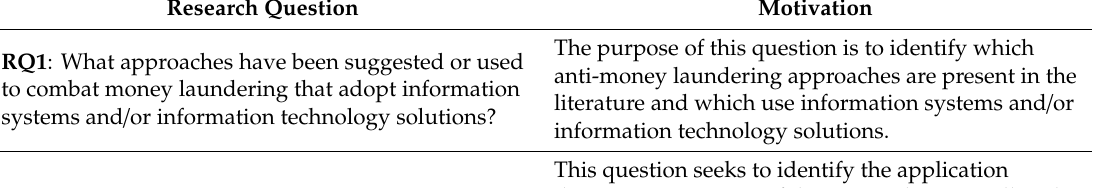
Table 1. Research questions of the systematic literature review